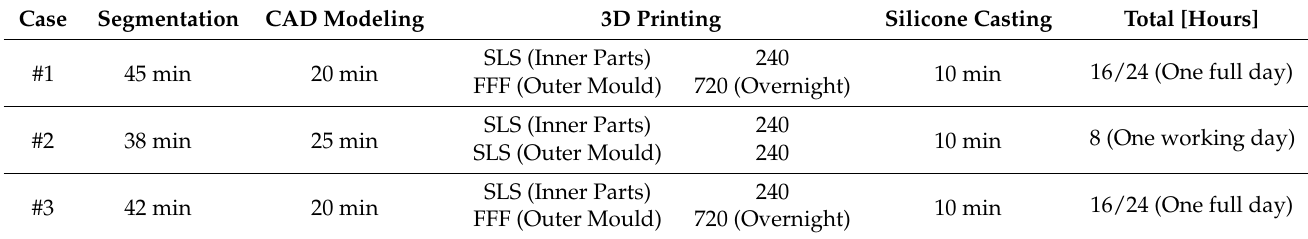
Table 3. Time taken in each step of the process following the digital workflow for 3D